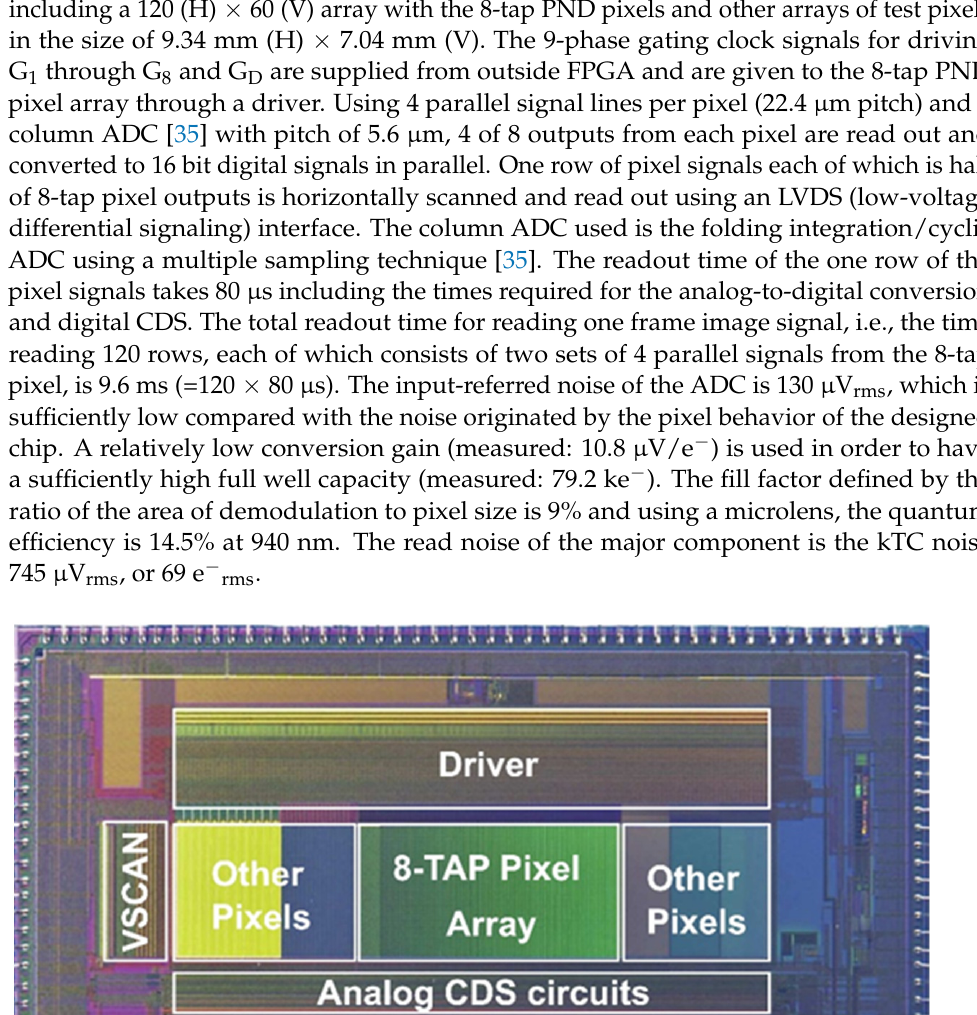
Figure 6. Chip micrograph. The dark current of the 8-tap demodulator pixel is measured at 60 ◦ C using one of the 8-tap outputs (the 6th tap) and two different measurement conditions: One is the static gate voltage setting of G 6 : High, G D : Low, and the other gates (G 1 –G 5 , G 7 , G 8 ): Low, and the other is the dynamic gate driving, as shown in the timing diagram of Figure 4. In the dynamic gate driving, the gates G 6 and, G D are pulsed with T 0 = 10 ns and T C = 250 ns, and the other gates (G 1 –G 5 , G 7 , G 8 ) are statically set to Low. In the static gate voltage setting, the dark current generated in all the aeras of the demodulators are captured in the FD of the 6th tap and the dark current in this case is 506 pA/cm 2 or 15.9 ke − /s with 22.4 µ m pixel. In the dynamic gate driving, the dark current is reduced to 166 pA/cm 2